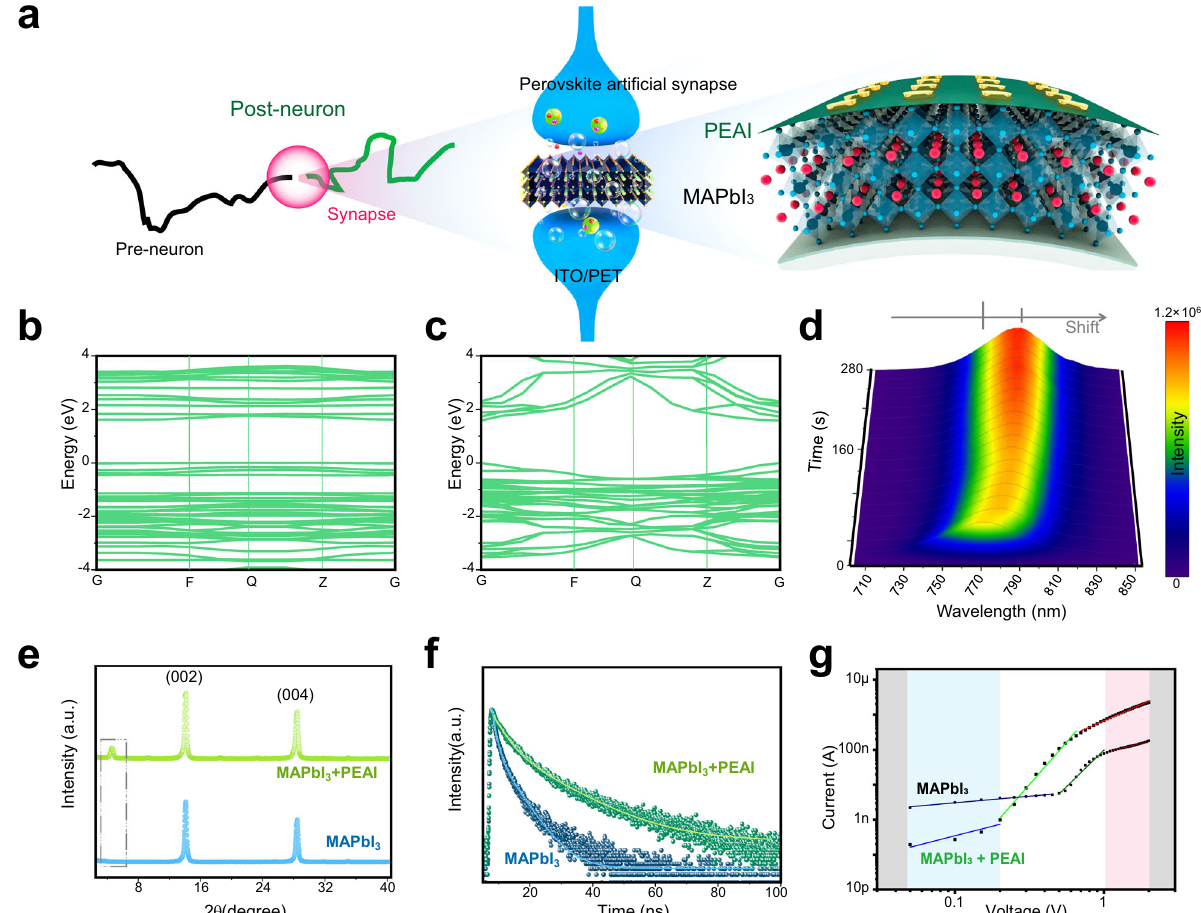
Fig. 1 | Concepts and materials. a Schematic diagrams of biological neuron/ synapse and perovskite arti fi cial synaptic device. b , c Energy band calculation of MAPbI 3 (cid:129) n(MA) and MAPbI 3 . d Result of in-situ PL test. e XRD patterns of MAPbI 3